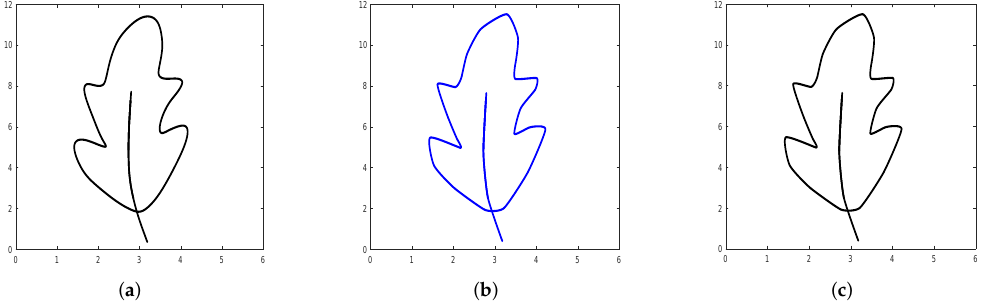
Figure 21. Leaf designing using cubic trigonometric B-spline curves. ( a ) Leaf designing at λ = 0. ( b ) Leaf designing λ = 0.35. ( c ) Leaf designing λ =